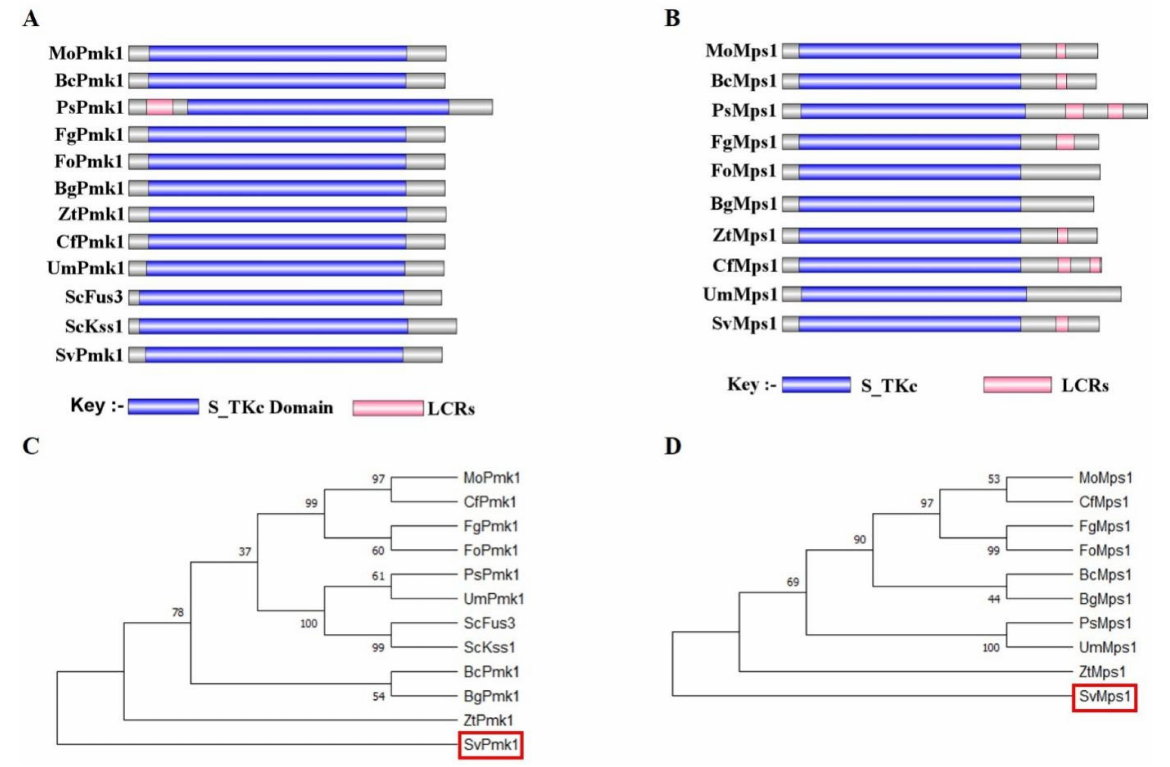
Figure 1. Domain architecture and phylogeny of Pmk1 and Mps1 in different fungi. S. cere- visiae Kss1 (NP_011554), S. cerevisiae Fus3 (AAA34613.1), M. oryzae Pmk1 (XP_003712175), Botrytis cinerea Pmk1 (XP_024547333.1), Puccinia striiformis Pmk1 (KNE97907.1), Fusarium graminearum Pmk1 (XP_011325047.1), F. oxysporum Pmk1 (XP_018244117.1), Blumeria graminis Pmk1 (AAG53654.2), Zy- moseptoria tritici Pmk1 (XP_003851863.1), Colletotrichum fructicola Pmk1 (XP_031881962.1), Ustilago may- dis Pmk1 (XP_011389711.1). M. oryzae Mps1 (XP_003712437), Botrytis cinerea Mps1